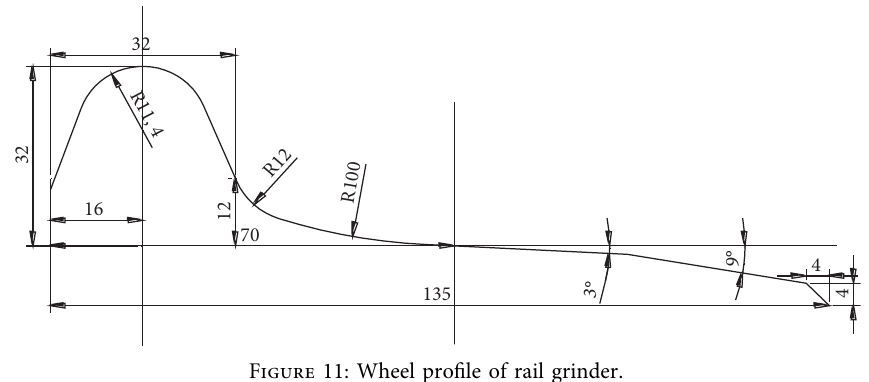
Figure 11: Wheel profile of rail grinder.